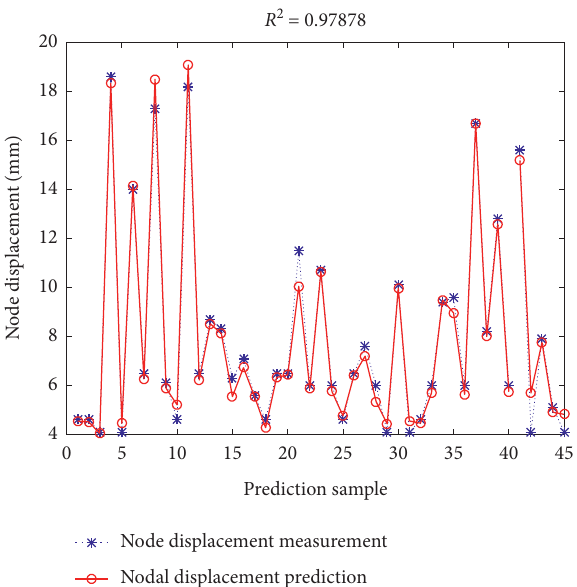
Figure 15: Comparison of prediction results of maximum displacement of nodes under the inner brace.